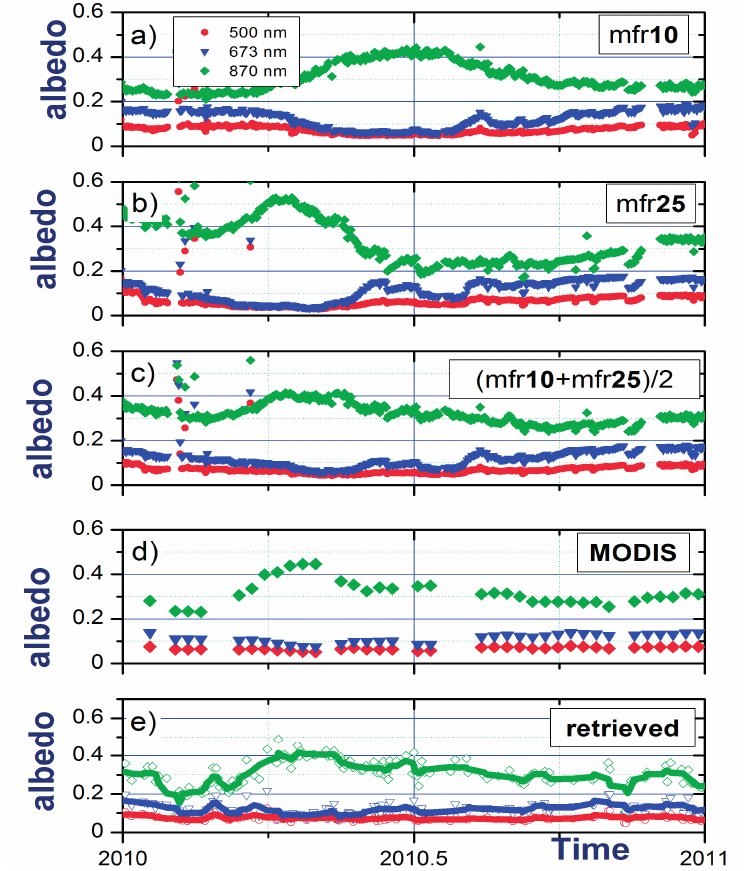
Figure 5. Time series of the tower-measured 10-m ( a ) and 25-m ( b ) surface albedo at the ARM site, their weighted average ( c ), MODIS-derived ( d ) and MFRSR-retrieved areal-averaged surface albedo ( e ) for one-year period (2010). Red, blue and green colors define the surface albedo values (a–c,e) at three MFR/MFRSR wavelengths (500, 673 and 870 nm). The MODIS data have been interpolated to these MFRSR wavelengths; (e) Solid lines (red, green, and blue) represent the smoothed versions of MFRSR-retrieved surface albedos at these wavelengths (500, 673 and 870 nm) (boxcar averaging; 5 points). Appendix C includes related version of Figure 5 for other years and wavelengths.